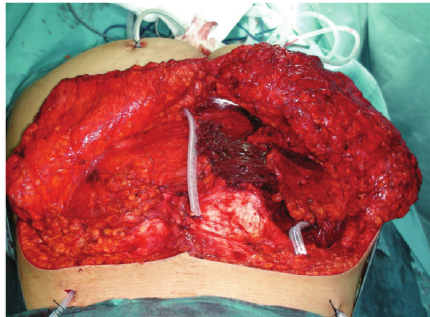
Figure 13: Rotational flaps of the gluteus maximus provided for soft tissue reconstruction and wound